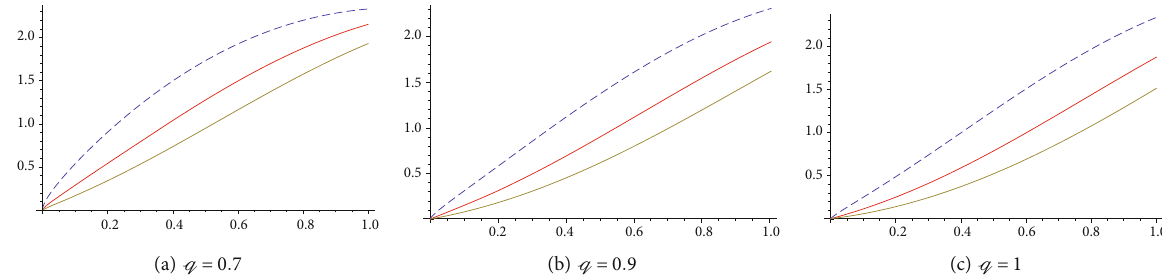
Figure 2: Plots of approximate solutions for Example 1, when p = 0 : 8 (dashed), p = 1 (red), and p = 1 : 2